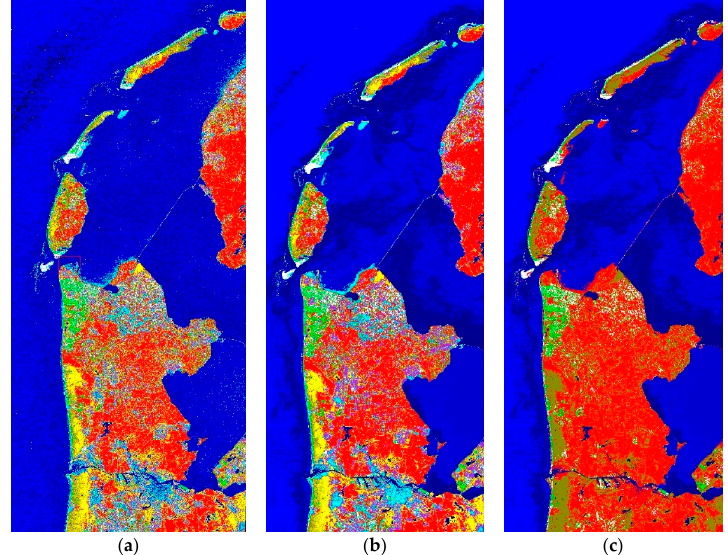
Figure 9. ( a ) Basic classification image; ( b ) Classification image after majority analysis processing; ( c ) Reclassification map after combination.